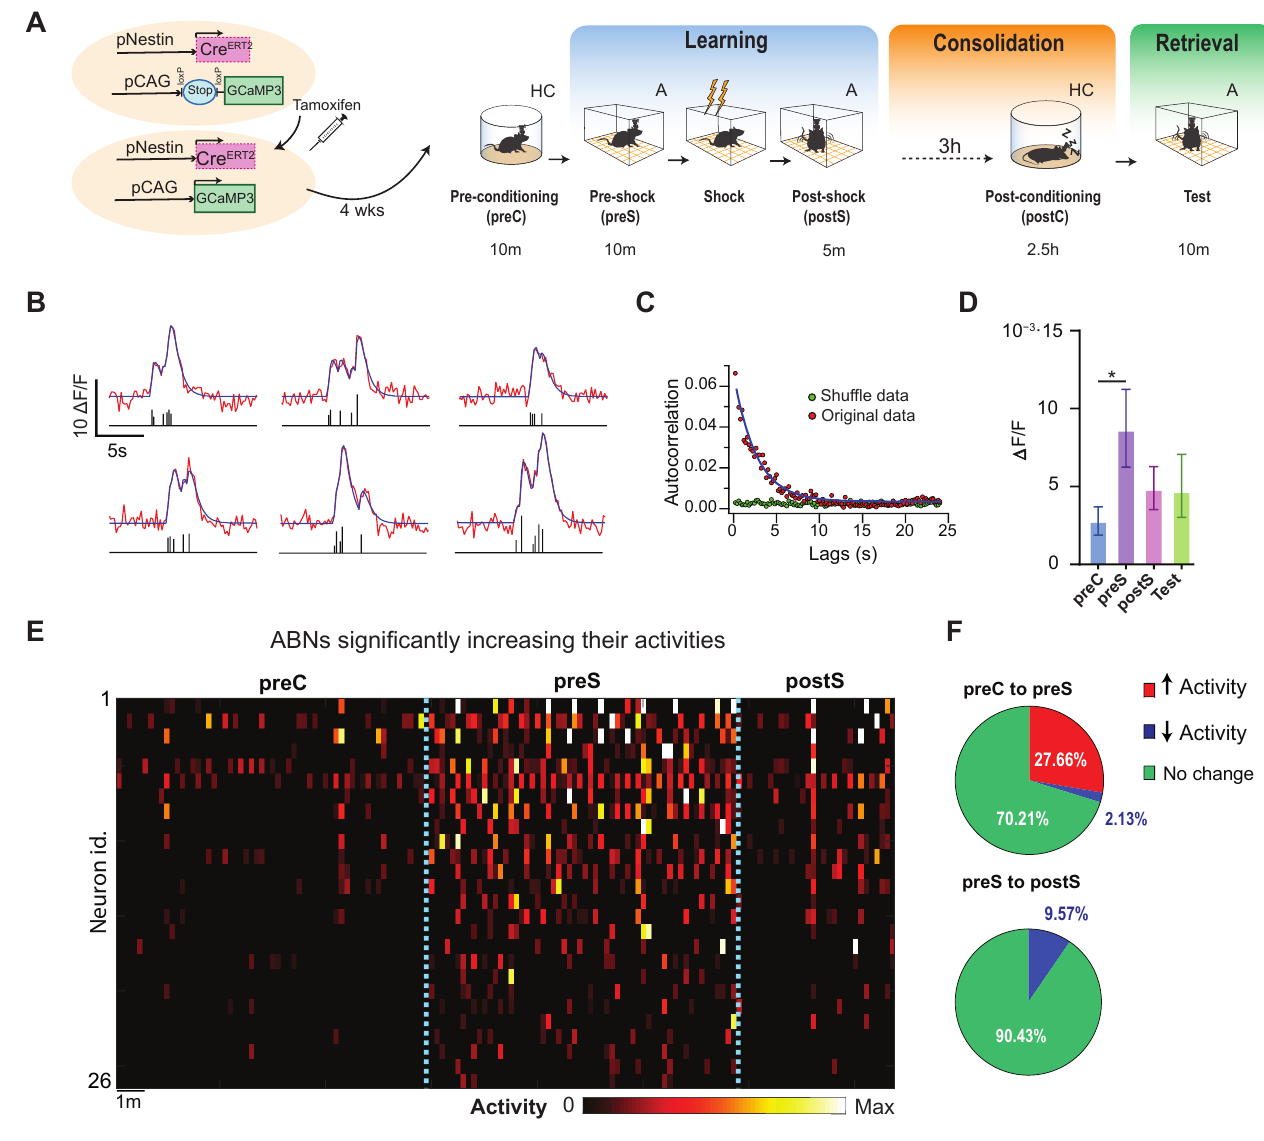
Figure 1. Adult-born neuron (ABN) activity increases during novel context exposure. ( A ) Experimental design. ( B ) Six examples of Ca 2+ trace deconvolution. Raw signal (red, top) was decomposed into unitary Ca 2+ events with amplitude (height) and timing information (bottom, black bars). Overlaying blue traces (top) show reconstructed Ca 2+ signal. ( C ) Circular autocorrelation function of mean activity from actual data (red dots) and temporally shuffled data (green dots). The blue line is an exponential fit. ( D ) Mean unitary event activity in each session. Bootstrap, * p < 0.05; n = 94 neurons from 4 mice; error bars, 95% confidence interval. ( E ) Activity heatmap shows increased ABN activity in the preshock (preS) period. Block bootstrap; * p < 0.05; each time bin, 10 s. ( F ) Pie chart of ABN changing their activities from preconditioning (preC) to preS, and preS to postshock (postS) periods (red, increase; blue, decrease; green, no